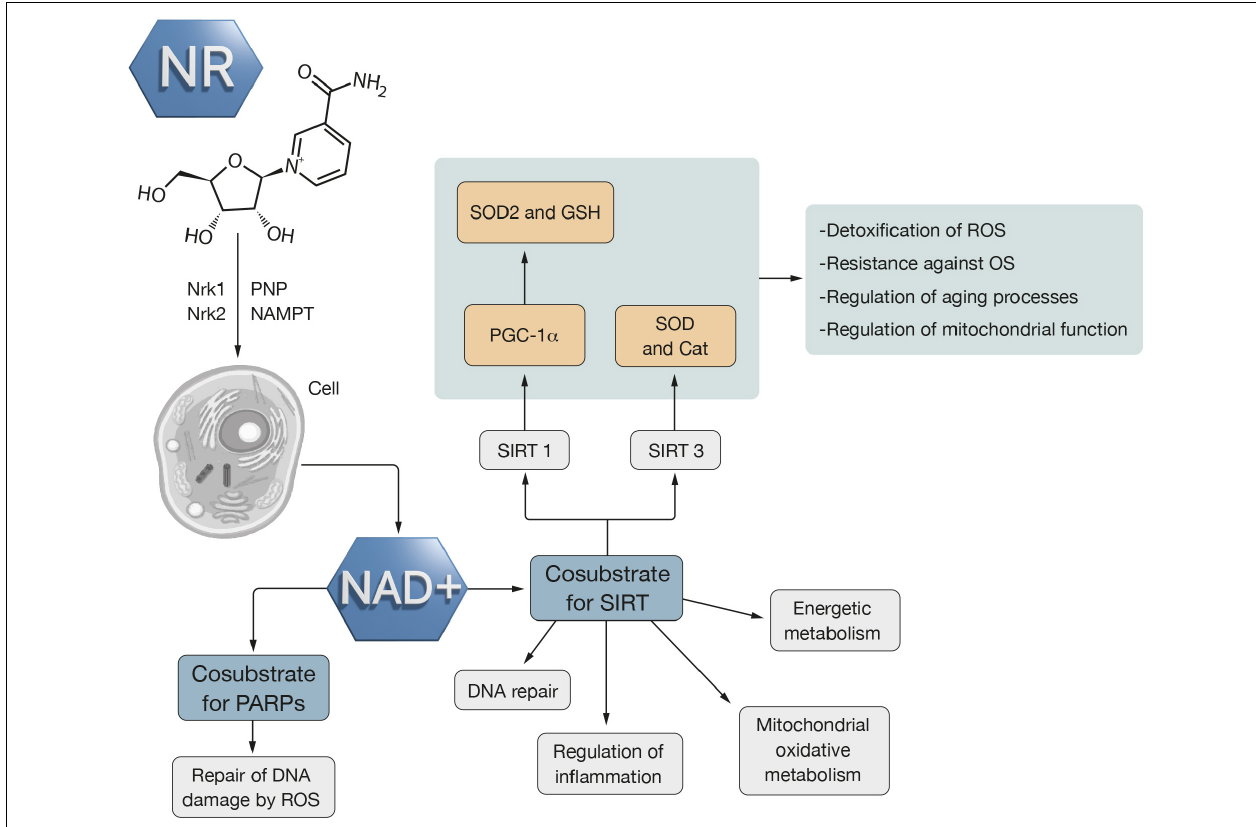
FIGURE 2 | Nicotinamide riboside action mechanism. NR gets into the cell and there, it is converted into NAD + through two mechanisms. One of them is Nrk1 and Nrk2 and the other is PNP and NAMPT. NAD + is a cosubstrate of PARPS which is related to repair of DNA damage by ROS. NAD + is also SIRT cosubstrate which is associated with energy metabolism, inflammation regulation, DNA repair and mitochondrial metabolism. The activation of SIRT increases the resistance against OS through an increase in metabolic pathways that detoxify ROS, like SOD2 and Cat. SIRT1 activates PGC-1 α which involves an increase of antioxidant defense through SOD2 and GSH. SIRT3 activates SOD2 and Cat. Thus, SIRT regulates mitochondrial function and aging processes as well as is involved in ROS